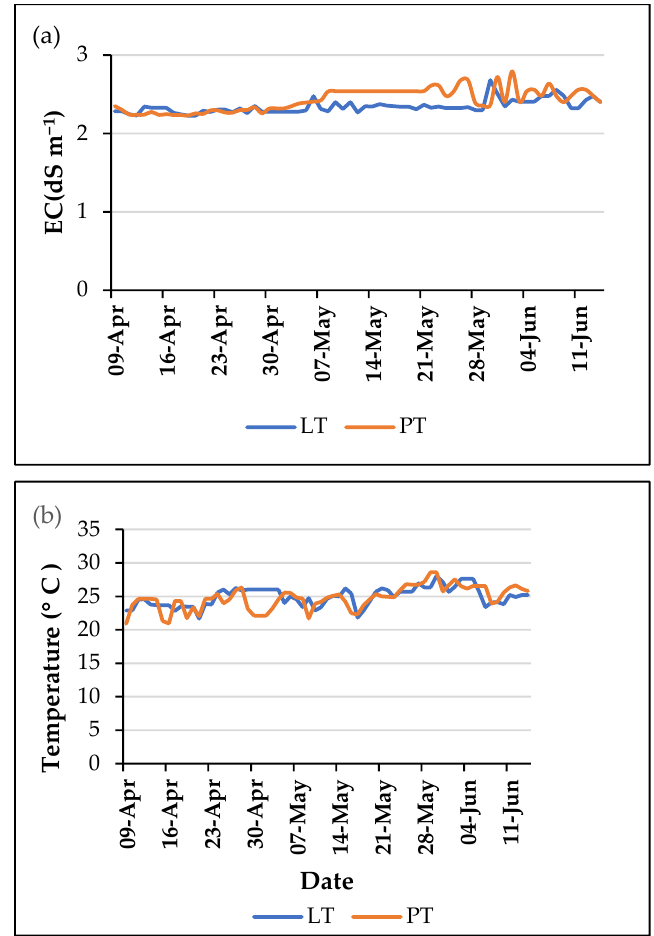
Figure 4. Nutrient solution electrical conductivity ( a ) and temperature ( b ).